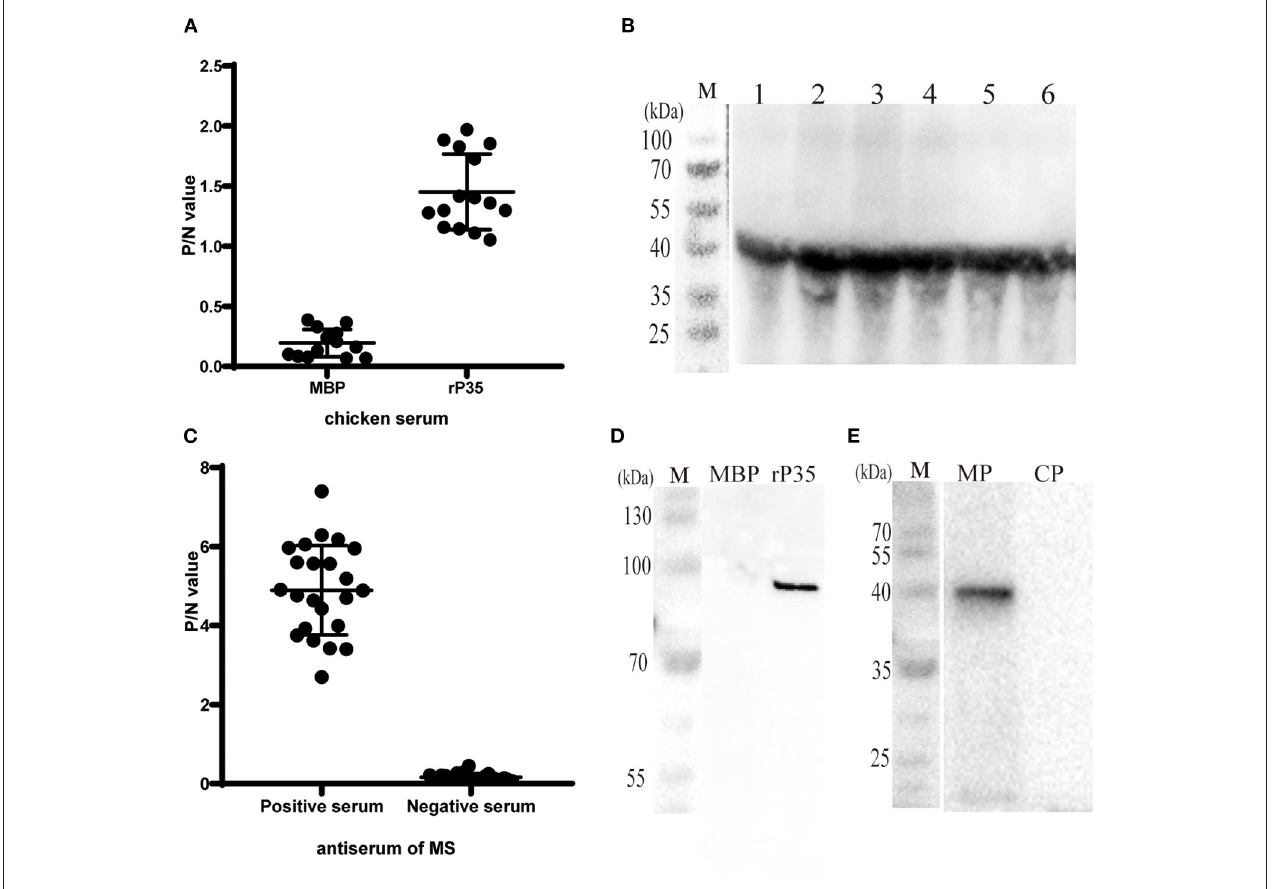
FIGURE 3 | Antigenicity analysis and localization of P35. (A) ELISA plates were coated with different Mycoplasma synoviae (MS) strains (10 8 CCU/well) and incubated with chicken serum against MBP and rP35 as the primary antibodies. (B) Western blotting assay of different MS strains incubated with chicken serum against rP35. (C) ELISAs were coated with rP35 and incubated with positive and negative specific pathogen-free (SPF) chicken serum against MS as the primary antibodies. (D) Western blotting assay of MBP and rP35 incubated with positive SPF chicken serum against MS. (E) Localization of P35. Western blotting assay was carried out after extracting the membrane protein of MS. MP means the membrane protein and CP means the cytoplasmic protein. The primary antibody used was SPF chicken serum against